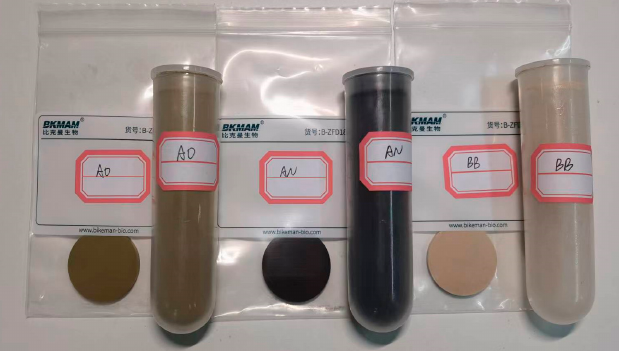
Figure 4. Biological spores and pressed tablets.(The tablets are stored in sealed bags)